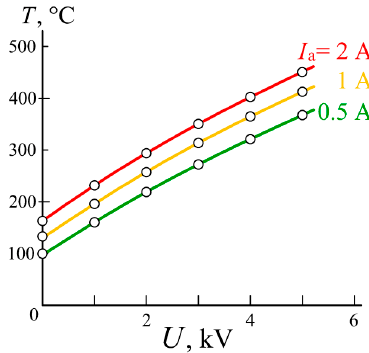
Figure 4. Dependence of the reamer temperature T on the grid bias voltage U at the argon pressure p = 0.5 Pa and various values of the discharge current I a .